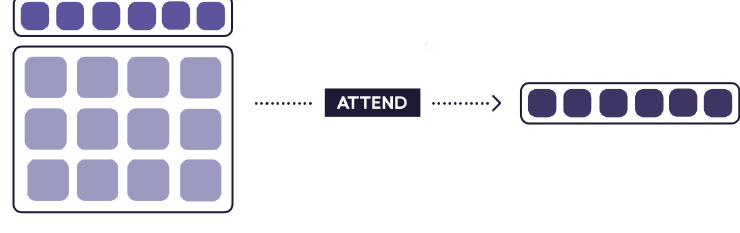
Figure 5. Attend